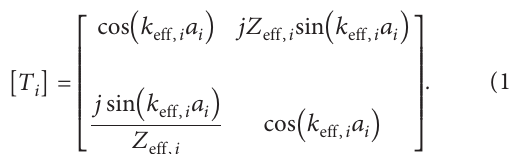
Figure 3: (a) Different simulation results for spiral unit combinations of distances h the combination of “9.75–22mm” array. (b) Pressure distributions of four peak frequency